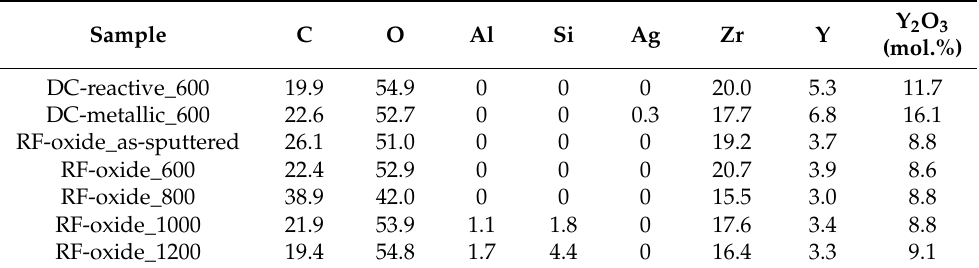
Table 3. XPS surface survey of selected YSZ thin films. The concentration is expressed in at.%, unless otherwise